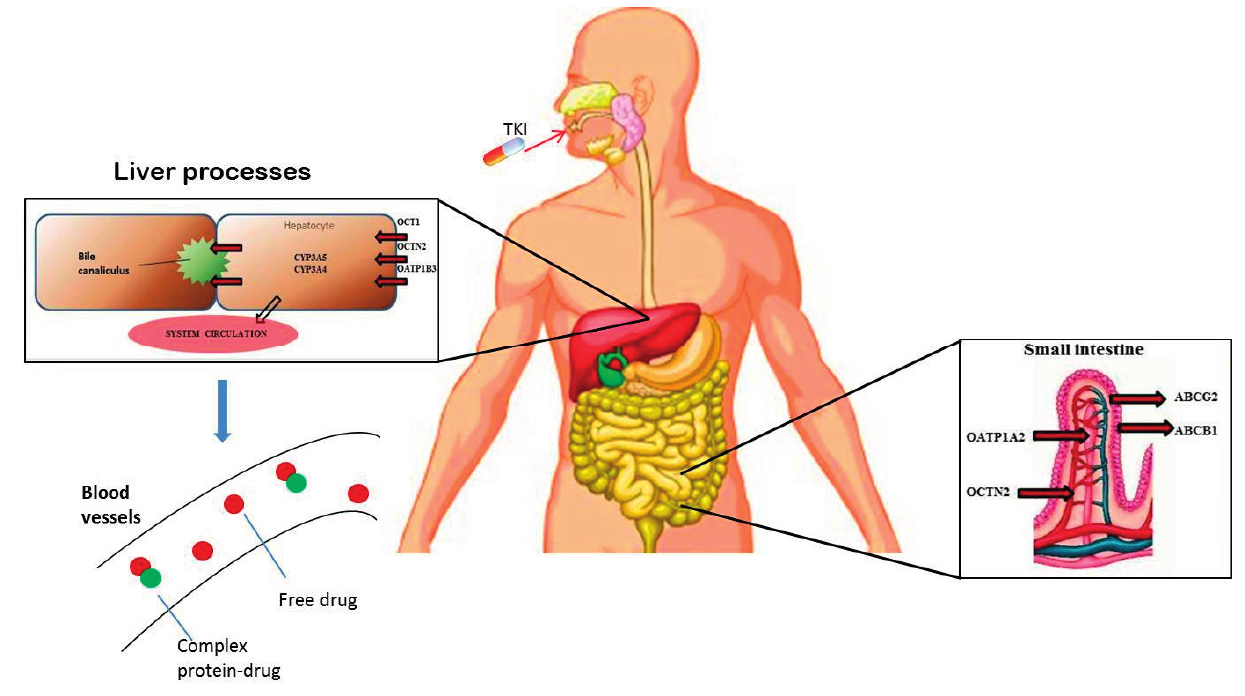
Figure 1. The main players in imatinib